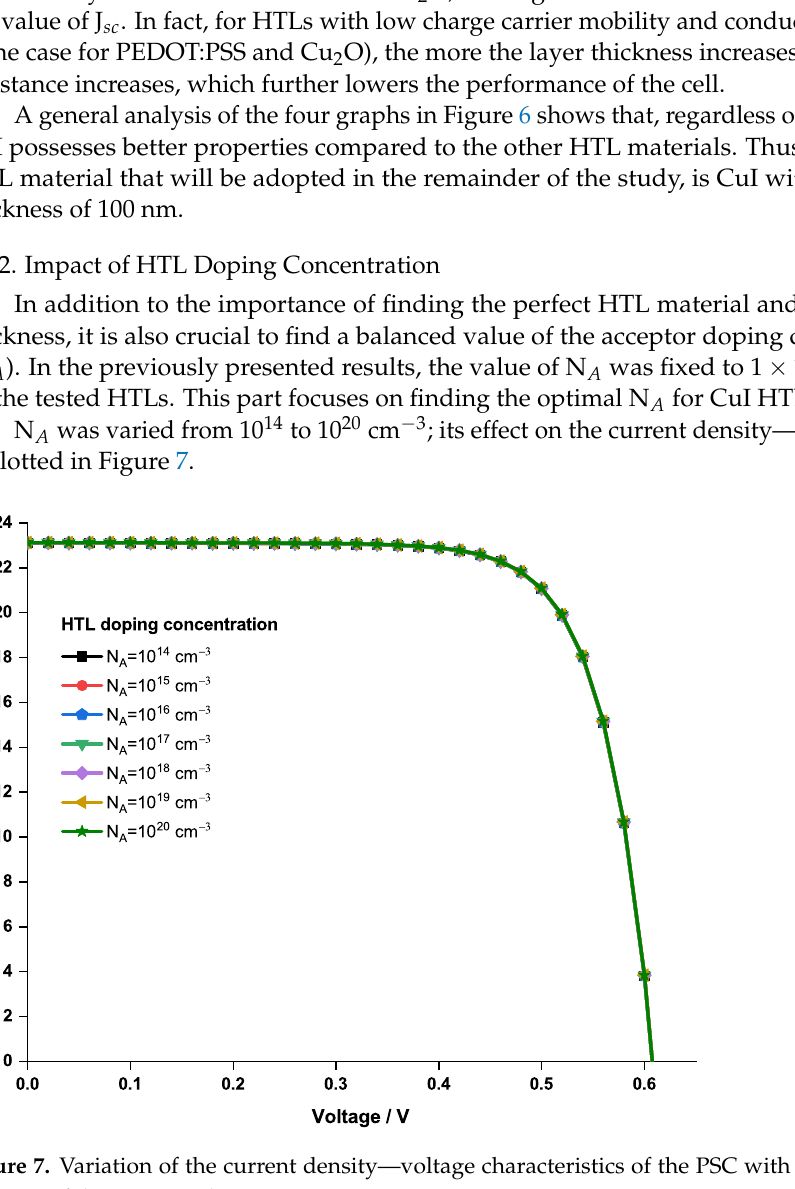
Figure 7. Variation of the current density—voltage characteristics of the PSC with CuI as HTL as function of the acceptor doping